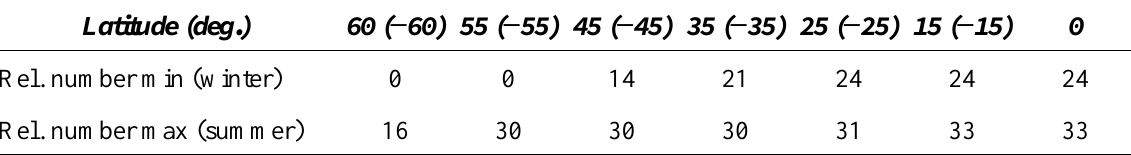
Table 1. Relative percentage of hours used in the construction of daily means of SSI in HC-1, knowing that maximum is 33% for B2 data